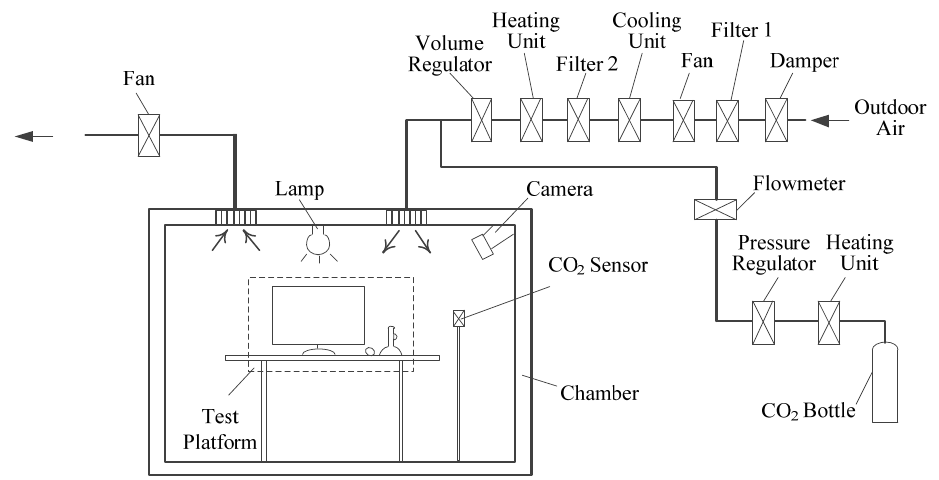
Figure 1. Schematic diagram of the environment chamber.